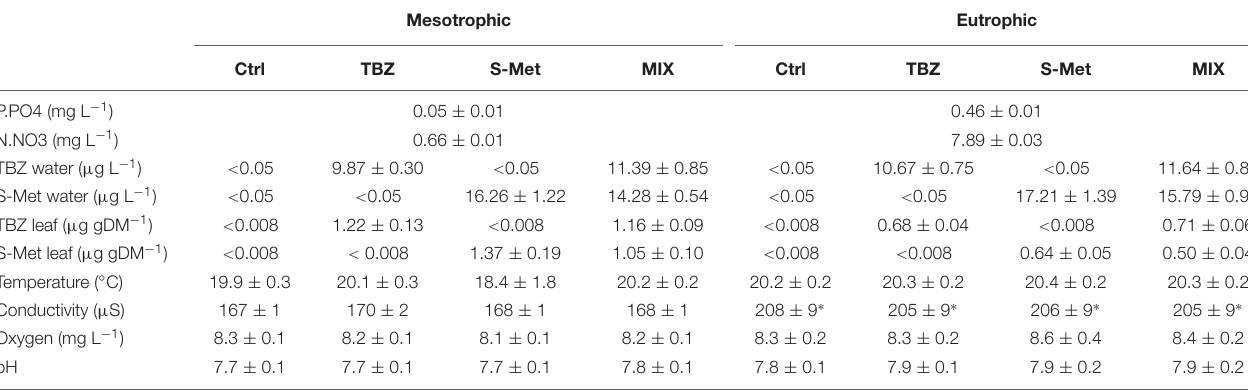
TABLE 1 | Water physical and chemical characteristics measured after each water renewals in experimental stream channels exposed to fungicide (TBZ), herbicide (S-Met), both fungicide + herbicide (MIX) or non-exposed (Ctrl) in either mesotrophic or eutrophic nutrient